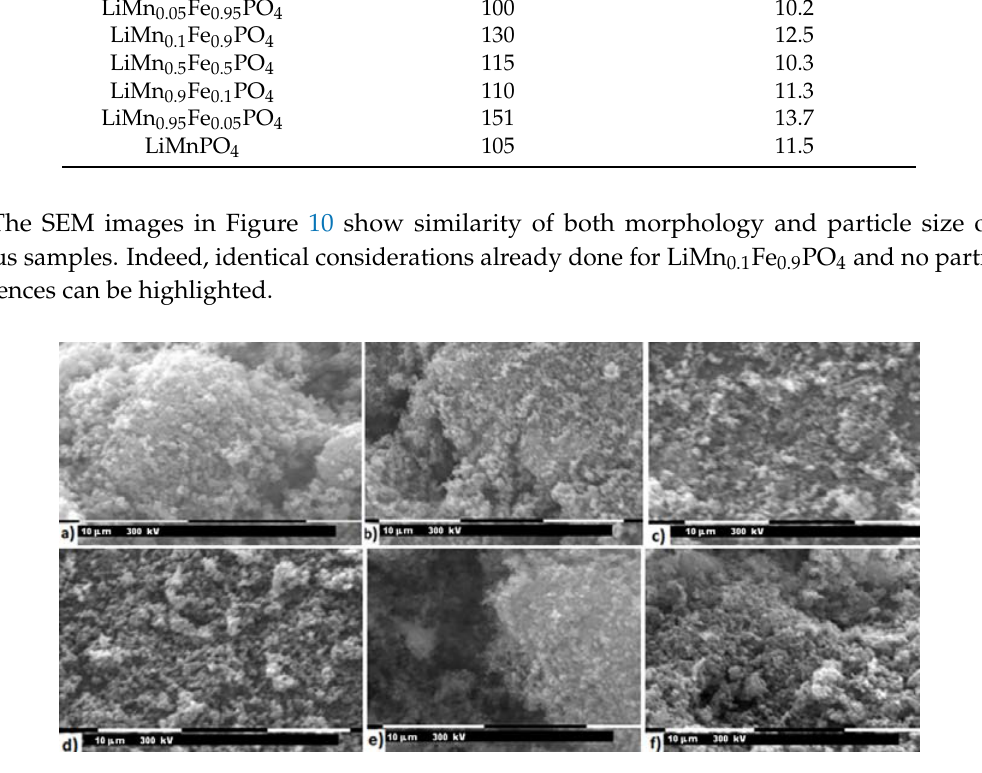
Figure 11. Results of tests at C/5 for LiMn x Fe (1 − x) PO 4 (x = 0.05; 0.1; 0.5; 0.9; 0.95): ( a ) Charge ‐ discharge curves; and ( b ) specific capacity.